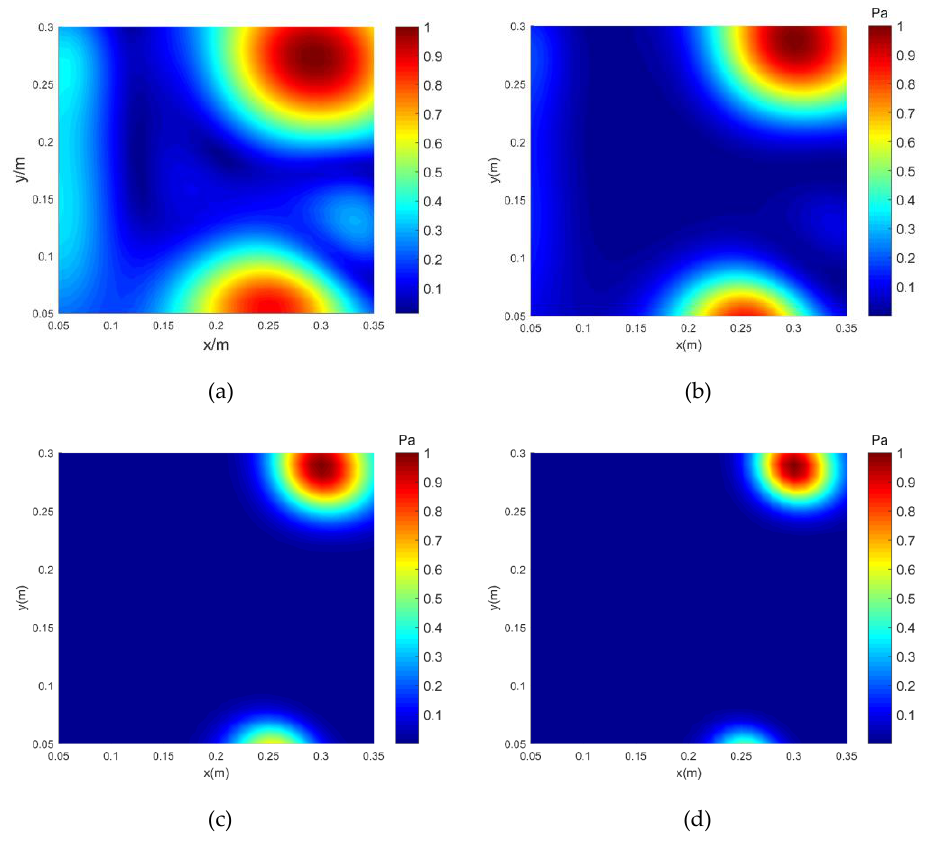
Figure 13. Pressure distributions under experimental conditions of ( a ) ERDCESM with ν = 0, ( b ) ERDCESM with ν = 1, ( c ) ERDCESM with ν = 3 and ( d ) ERDCESM with ν = 5 for a plate sound source at 500 Hz.